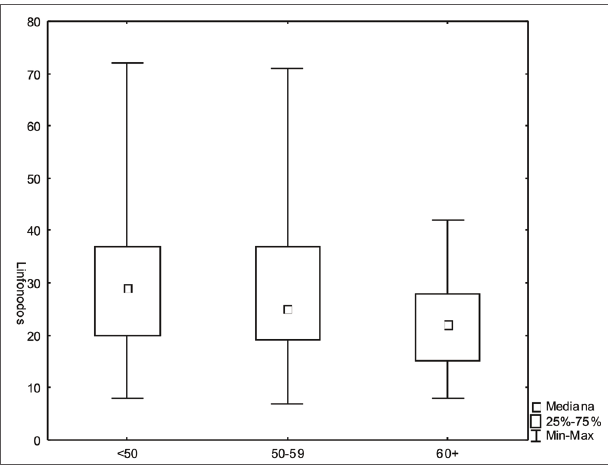
Figura 3. Número de linfonodos conforme a faixa etária ( p =0,01).